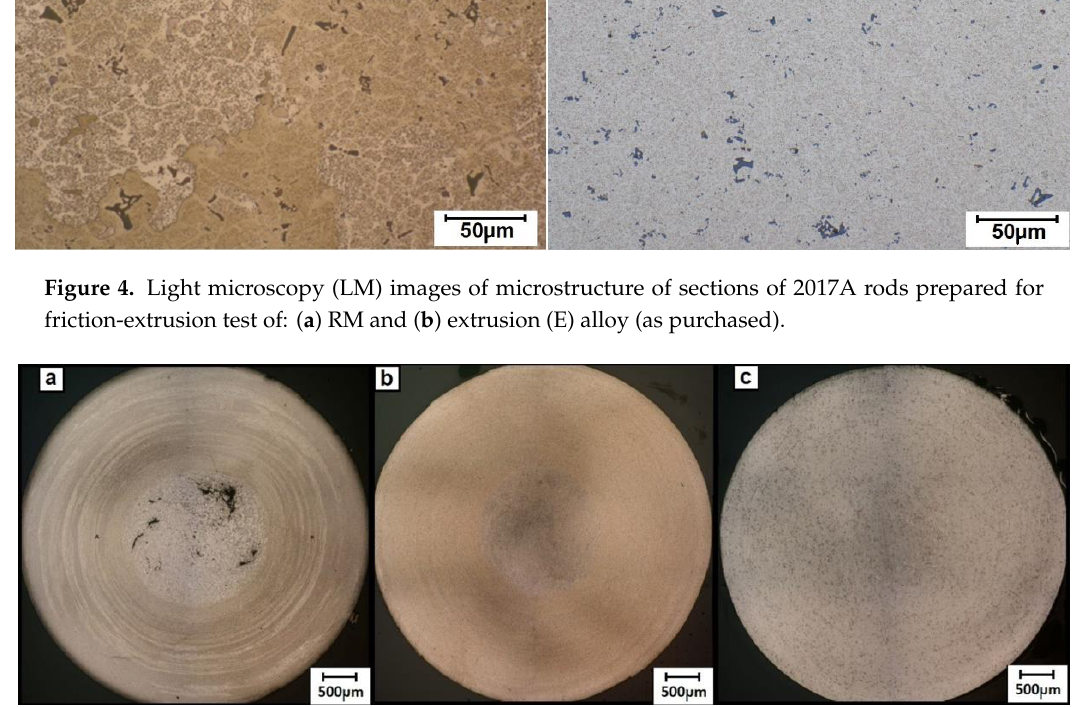
Figure 5. LM images of cross-sections of friction-extruded alloys processed at various rotations: ( a ) RM/224 rpm, ( b ) E/224 rpm and ( c ) E/315 rpm.